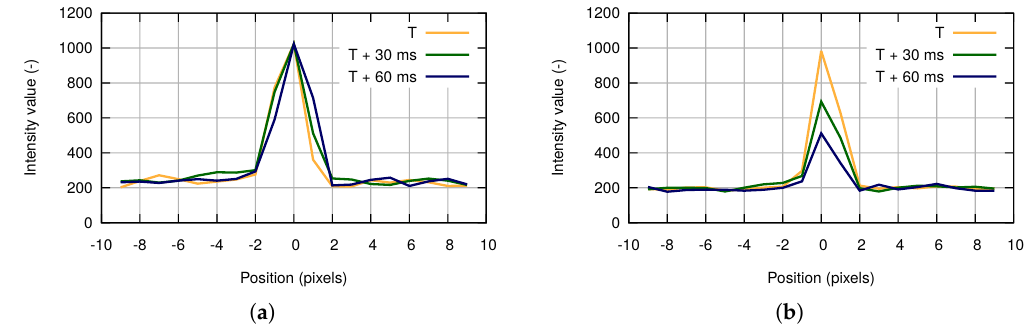
Figure 3. Profiles of the objects present in the frame. ( a ) Sampled meteor streak. ( b ) Stellar